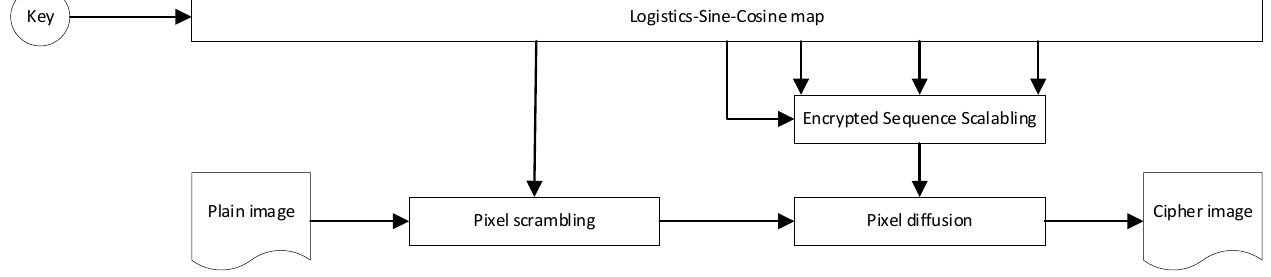
Figure 1. Encryption flowchart.